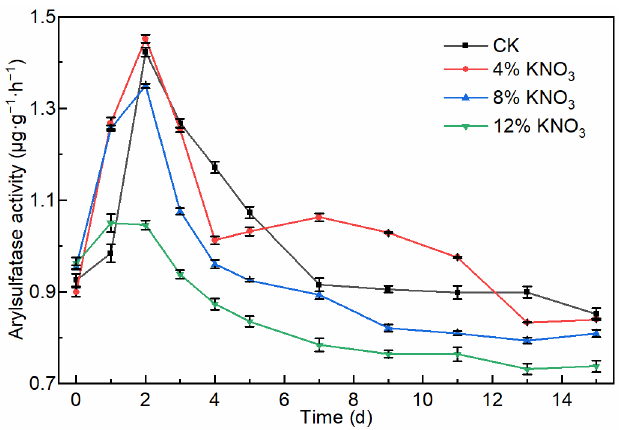
Figure 4. Variation in the arylsulfatase activity of the compost material under different KNO 3 addi- tions.